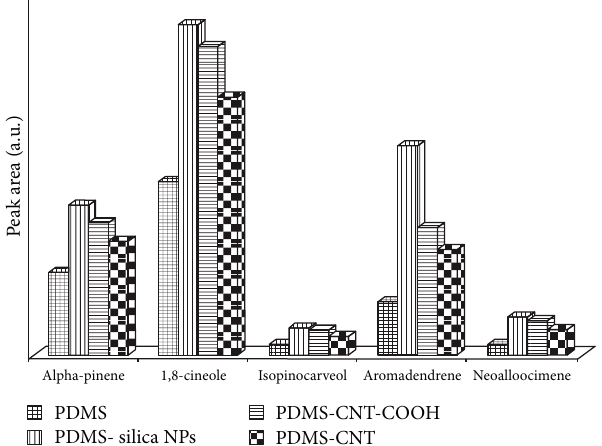
F 2: e effect of different nanomaterials incorporation on extraction capability of prepared